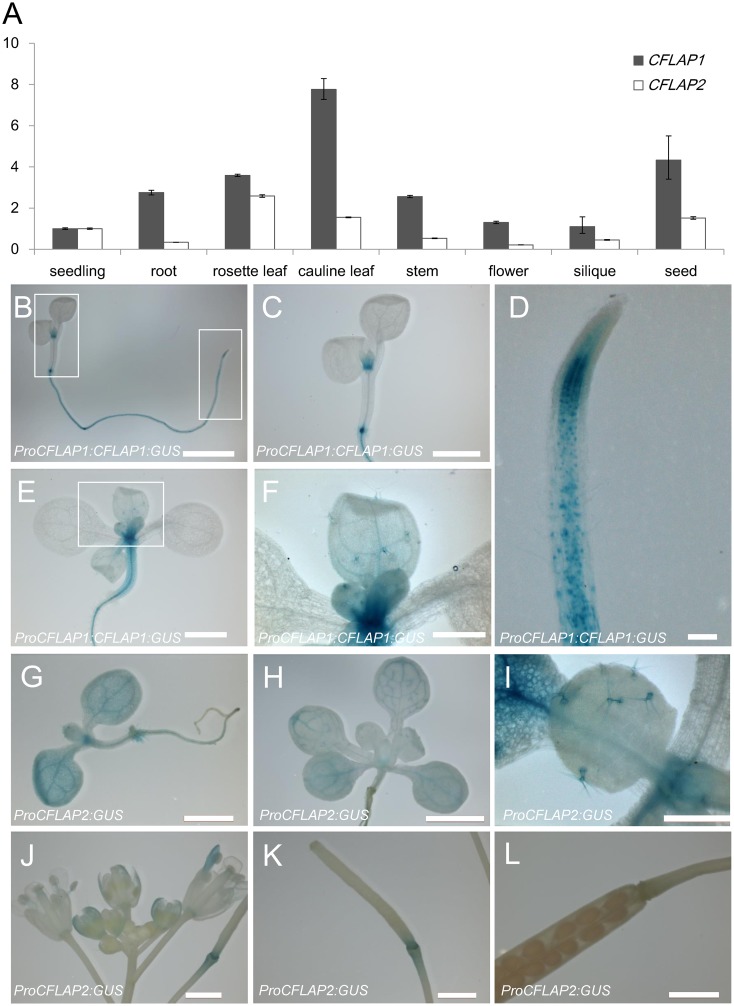
The expression patterns of CFLAP1 and CFLAP2.(A) Analysis of CFLAP1/2 expression levels in different organs of wild-type Arabidopsis by qRT-PCR. The expression level of seedling is set to 1.0, and error bars represent the SD of three biological replicates. (B) to (F) The expression pattern of CFLAP1 in Arabidopsis. (B) GUS-stained one-week-old seedling. (C) and (D) Higher magnification of boxed regions in (B). (E) GUS-stained two-week-old seedling. (F) Higher magnification of boxed region in (E). (G) to (L) The expression pattern of CFLAP2 in Arabidopsis. (G) GUS-stained one-week-old seedling. (H) GUS-stained two-week-old seedling. (I) GUS-stained trichomes in true leaves of two-week-old seedling. (J) GUS-stained inflorescence stem with buds, flowers, and siliques. (K) GUS-stained young silique. (L) GUS-stained the abscission zone of mature silique. Bars = 2 mm in (B) and (H), 1 mm in (C), (E), (G), (J), (K) and (L), 500 μm in (F) and (I), 100 μm in (D).